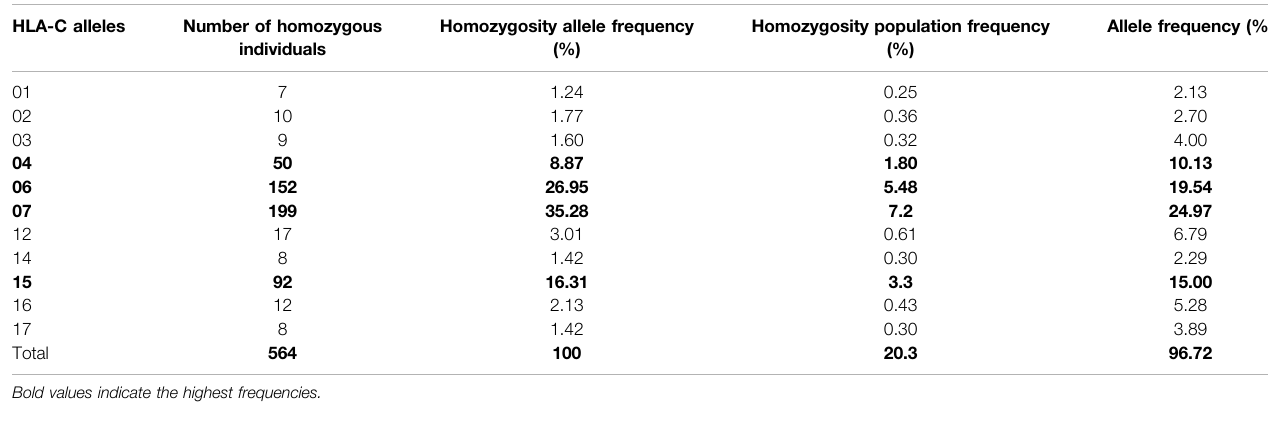
TABLE 3 | List of HLA-C alleles detected in locus C and the frequency of homozygosity and allele frequencies. HLA-C alleles Number of homozygous individuals